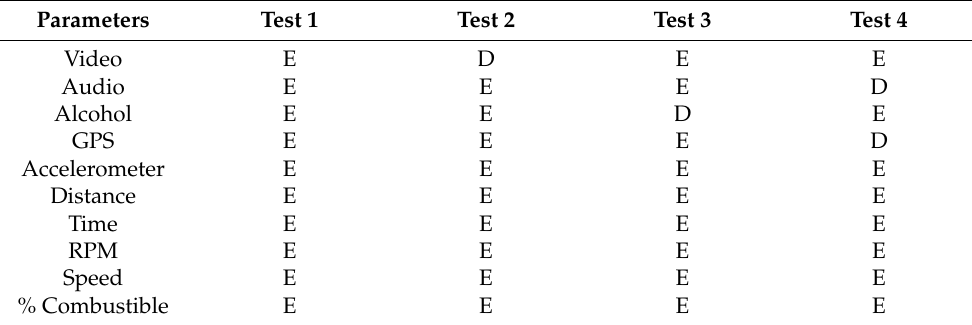
Table 2. Results of some of the tests carried out; E is enabled and D is disabled. Parameters